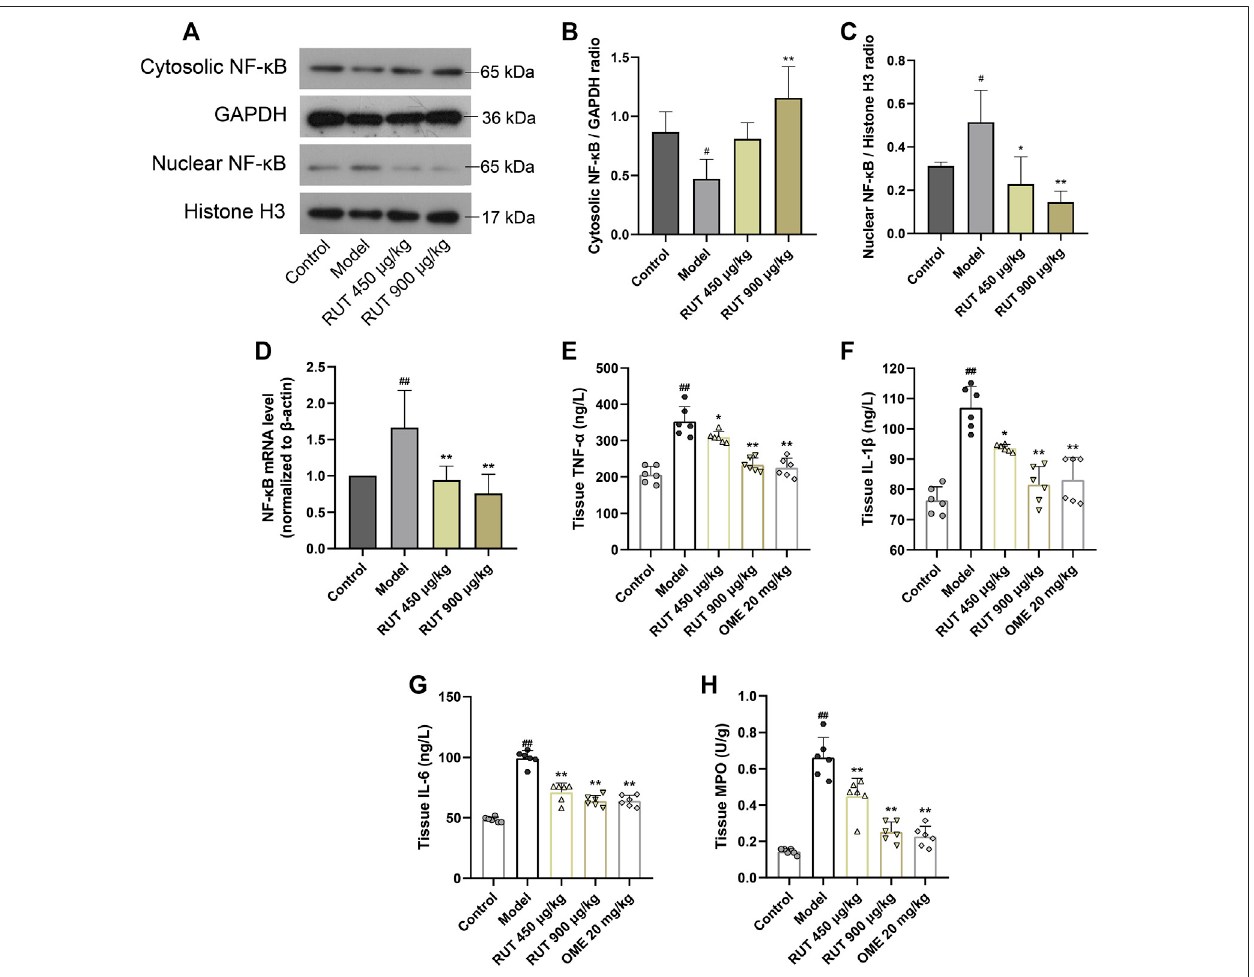
FIGURE3 | Effect ofRUT on in fl ammatoryfactors levels ingastric damage induced byethanol.Note: (A) Westernblot images ofcytosolicand nuclear NF- κ Bp65; (B) CytosolicNF- κ Bp65proteinlevel; (C) NuclearNF- κ Bp65proteinlevel; (D) NF- κ Bp65mRNAlevel; (E) TissueTNF- α level; (F) TissueIL-1 β level; (G) TissueIL-6level; (H) Tissue MPO level. Values are expressed as mean ± SD (n (cid:1) 6). # p < 0.05 and ## p < 0.01 when compared with the control group. * p < 0.05 and ** p < 0.01 when compared with the model group.